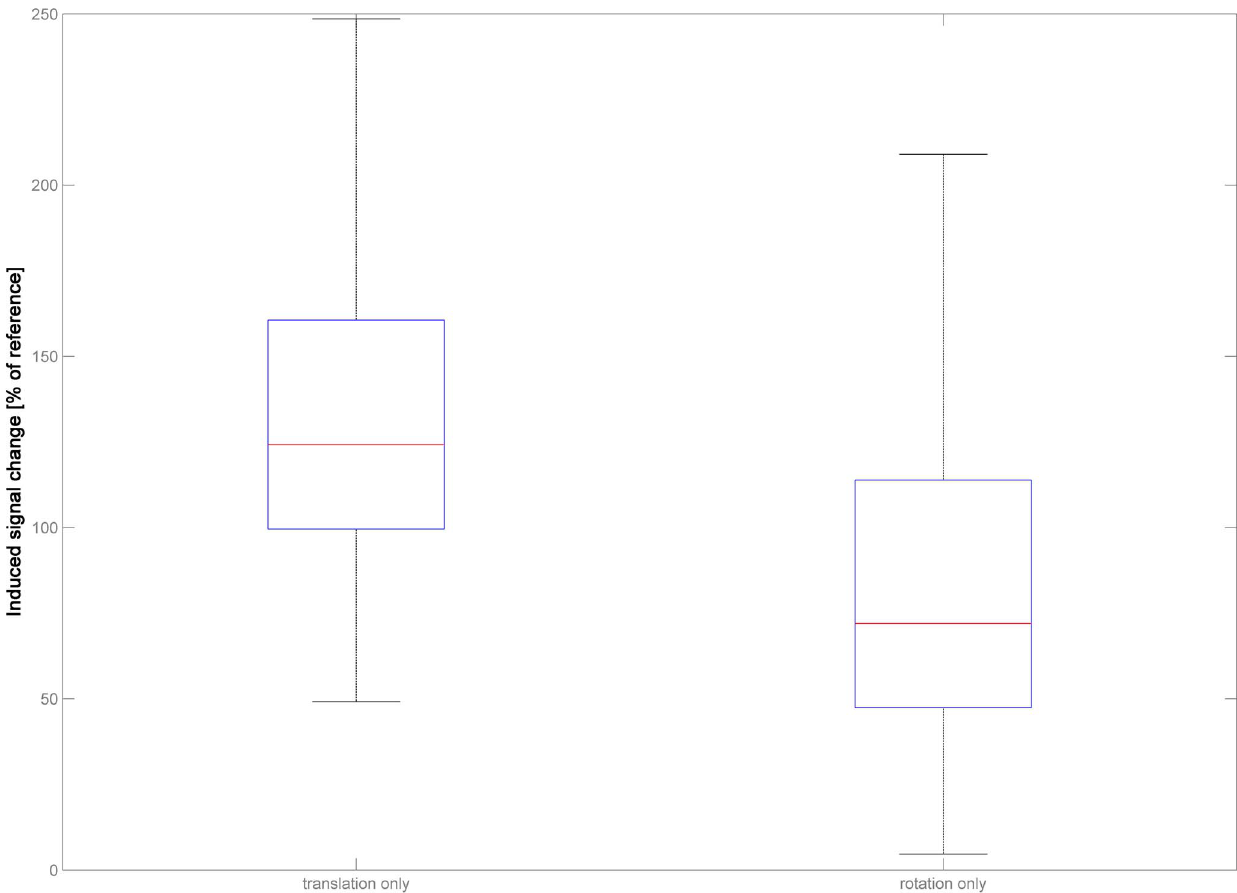
Figure 5. Illustration of the induced signal changes in dataset 3 (n=200) for the two reduced parameter sets (translation only , left panel, and rotation only , right panel). Note severe deviation from expected observable signal changes when compared with the signal changes induced by the full parameter set (=100%).